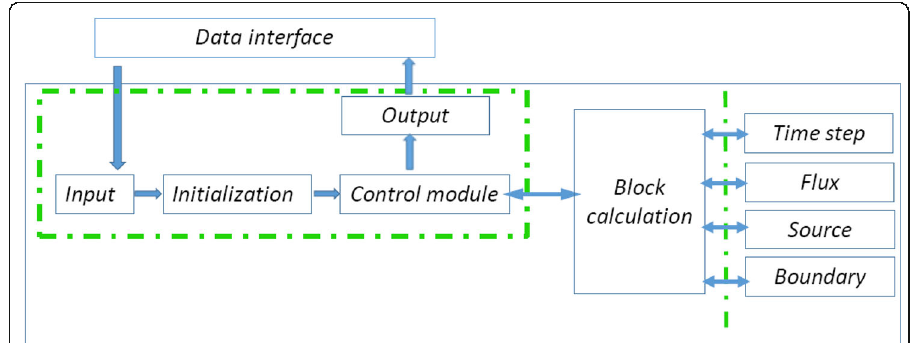
Fig. 3 Framework of UGKS solver